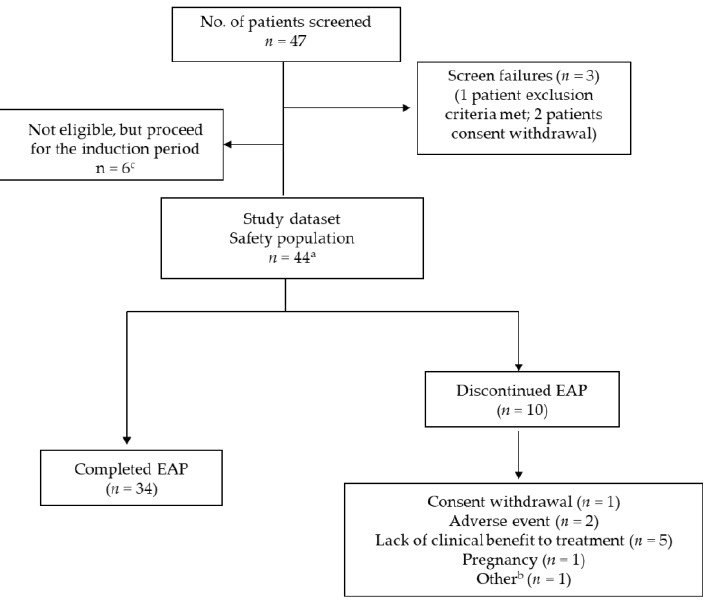
Figure 2. Flowchart. a: Patients who were administered at least one program treatment